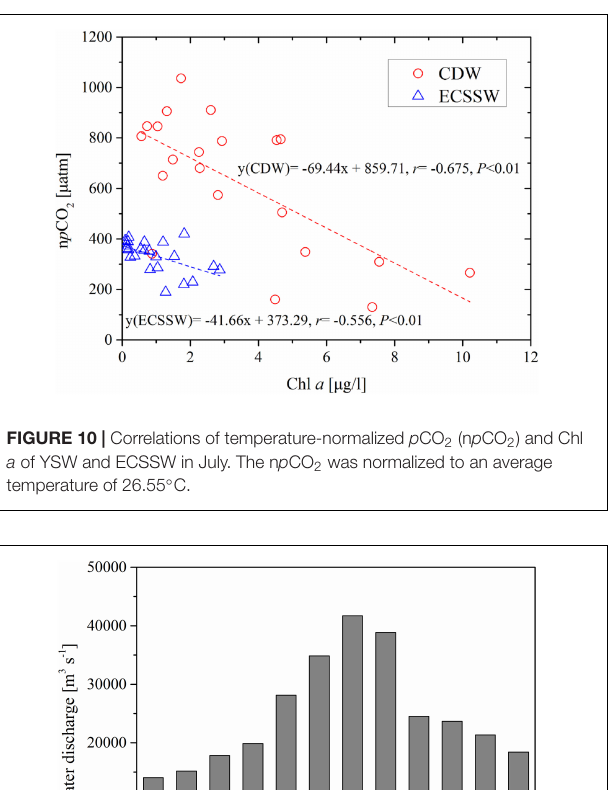
Frontiers in Marine Science |